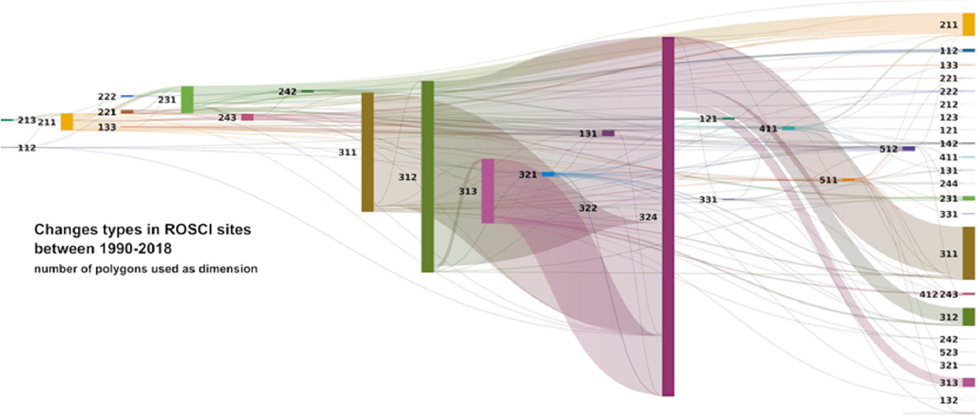
Figure 13. Land cover change dynamic in ROSCI sites, between 1990–2018.